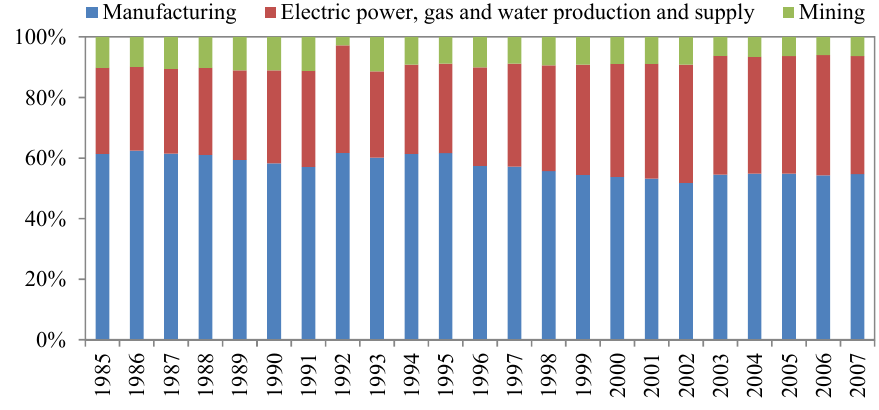
Figure 2. Contribution of energy-related CO